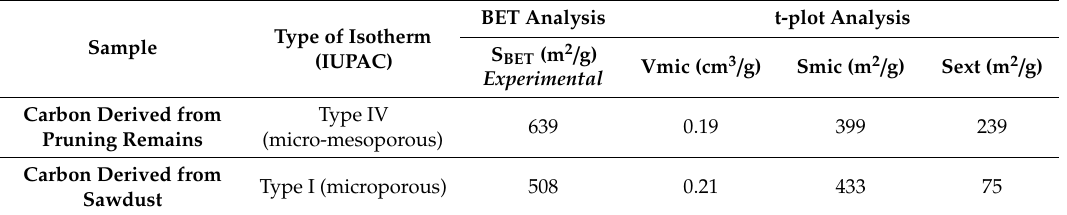
Table 1. Textural properties of activated carbons obtained from the different types of biomass.